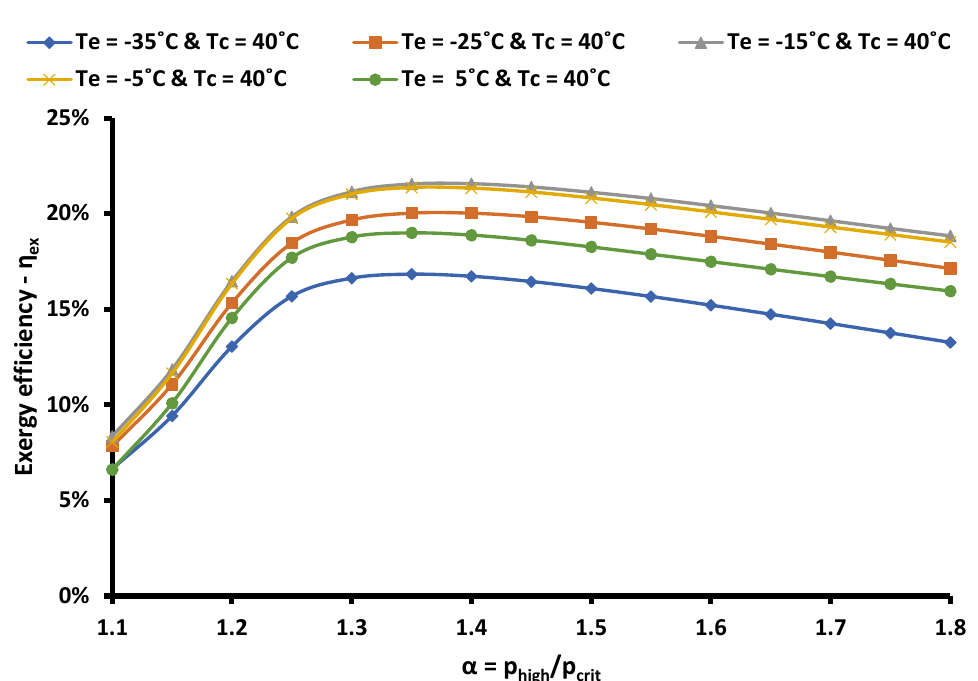
Figure 7. The impact of the pressure ratio parameter of the reference system exergy efficiency (T c = 40 °C).